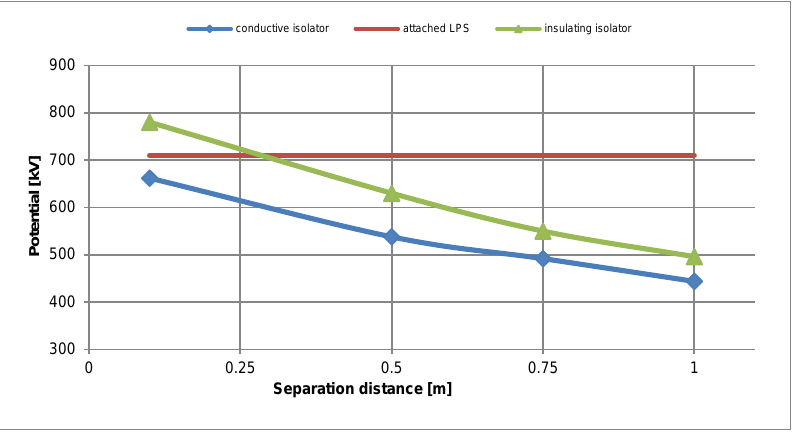
Figure 8. Maximum potential for soil structure D and three investigated external LPS systems (attached system, non-attached system with insulating isolator, and non-attached system with conductive isolator).